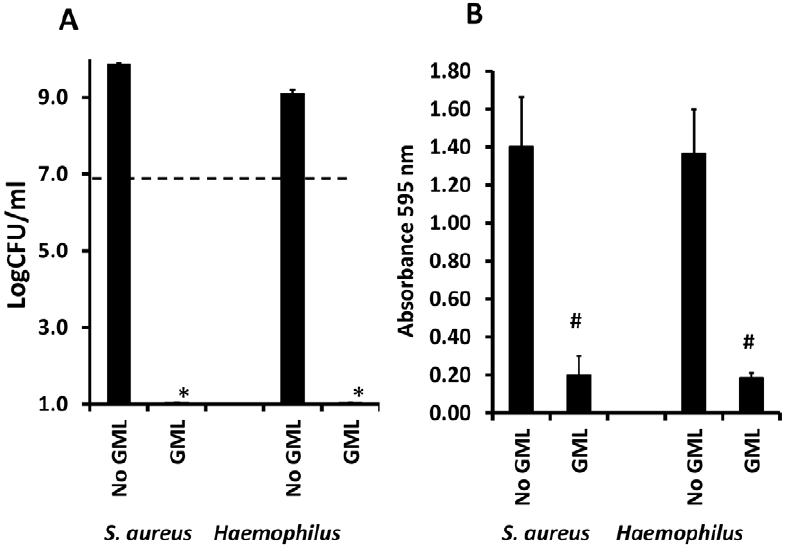
Figure 9. Ability of GML to remove pre-formed biofilms. Staphylococcus aureus MN8 and nontypable Haemophilus influenzae were grown for 48 hours in 96 well microtiter plates to allow biofilm formation. CFUs/ml were determined after suspension of organisms (A). Subsequently, the wells were treated or not treated with GML (500 m g/ml) for 60 min, and then CFUs/ml determined again (A). * indicates significant mean reduction compared to starting inoculum mean at p , 0.001. Dashed line indicates starting inoculum size. Wells were stained with crystal violet after removal of non-adherent bacteria or after removal of non-adherent bacteria and treatment with GML, followed by removal of unbound crystal violet and determination of absorbance at 595 nm (B). # indicates significant mean reduction in absorbance at 595 nm wavelength between no GML and GML- treated wells at p , 0.01.